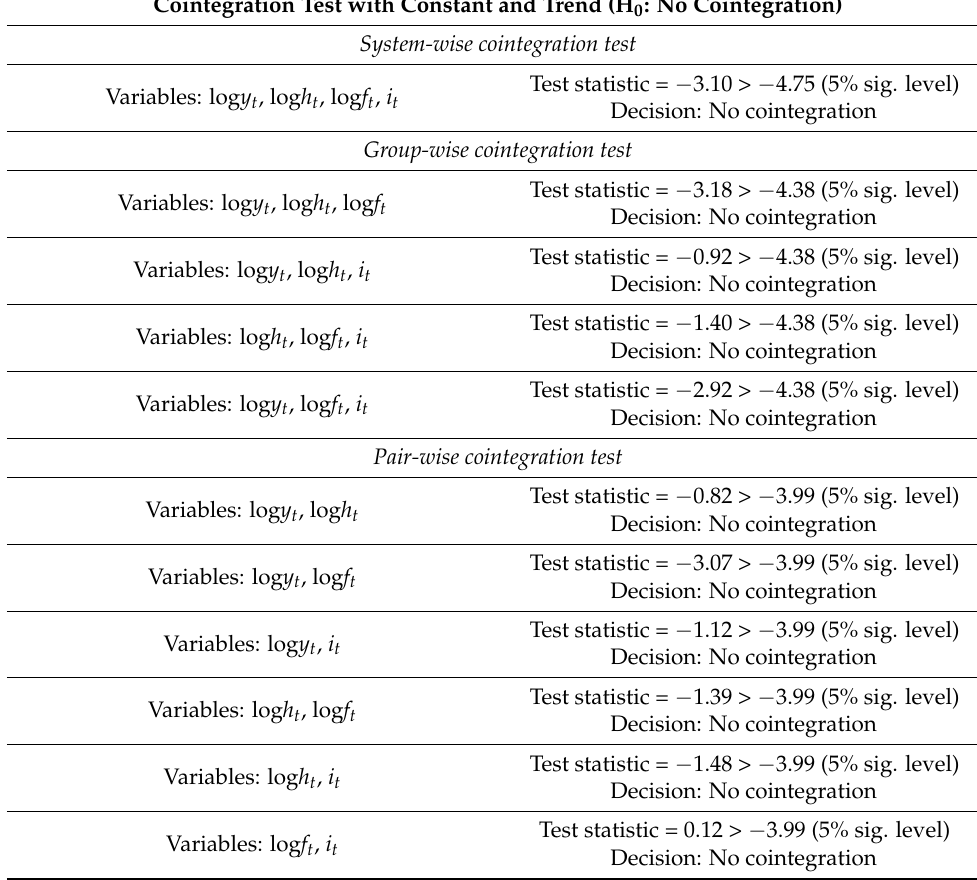
Table 2. Cointegration results. Cointegration Test with Constant and Trend (H 0 : No